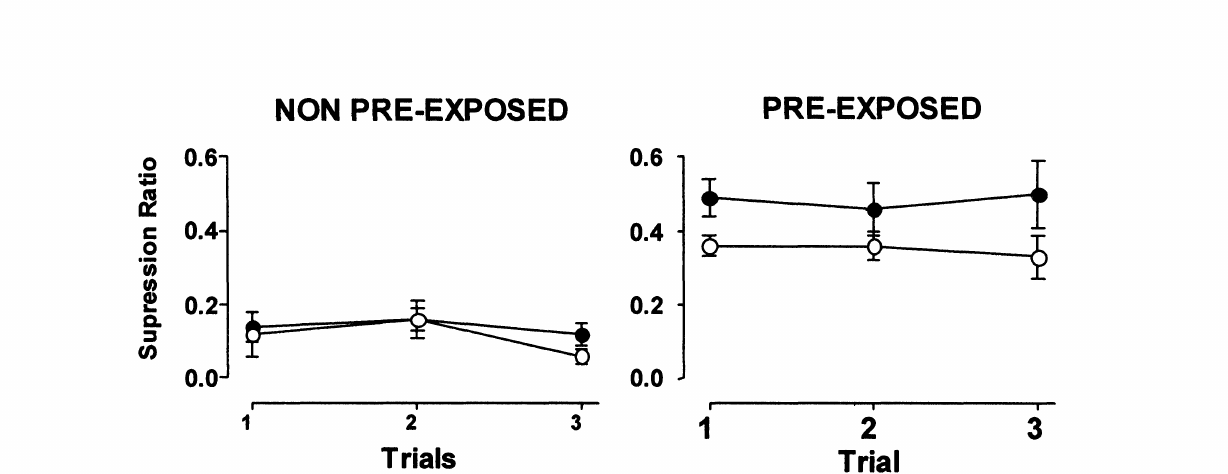
0.2 0.0- 0.0 Trials Trial Effect of chronic mild stress on the acquisition of a conditioned emotional response in rats non pre-exposed (left) and pre- Fig. 1: exposed to the conditioned stimulus (right). Mean suppression ratio + s.e.m, is plotted as a function of three successive trials. (o) chronically stressed; and (O) non-stressed